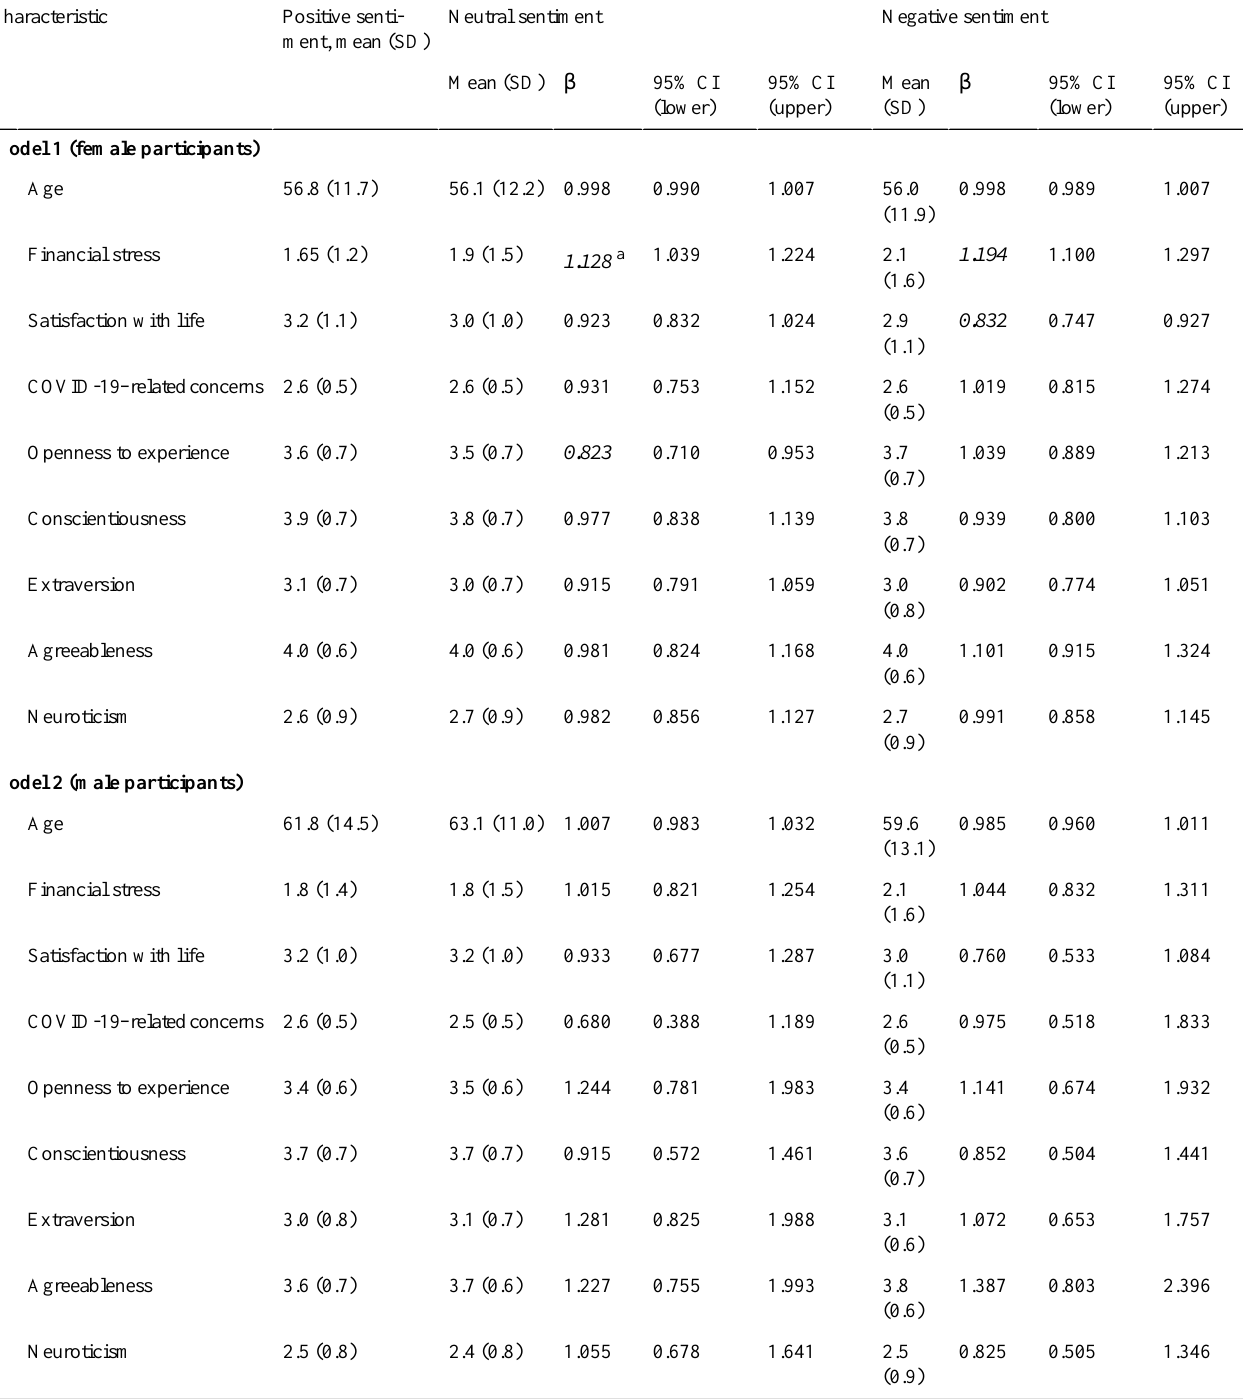
Table 3. Multinomial logistic regression identifying significant associations with COVID-19 sentiment among a sample of Australian adults reported in May 2020.